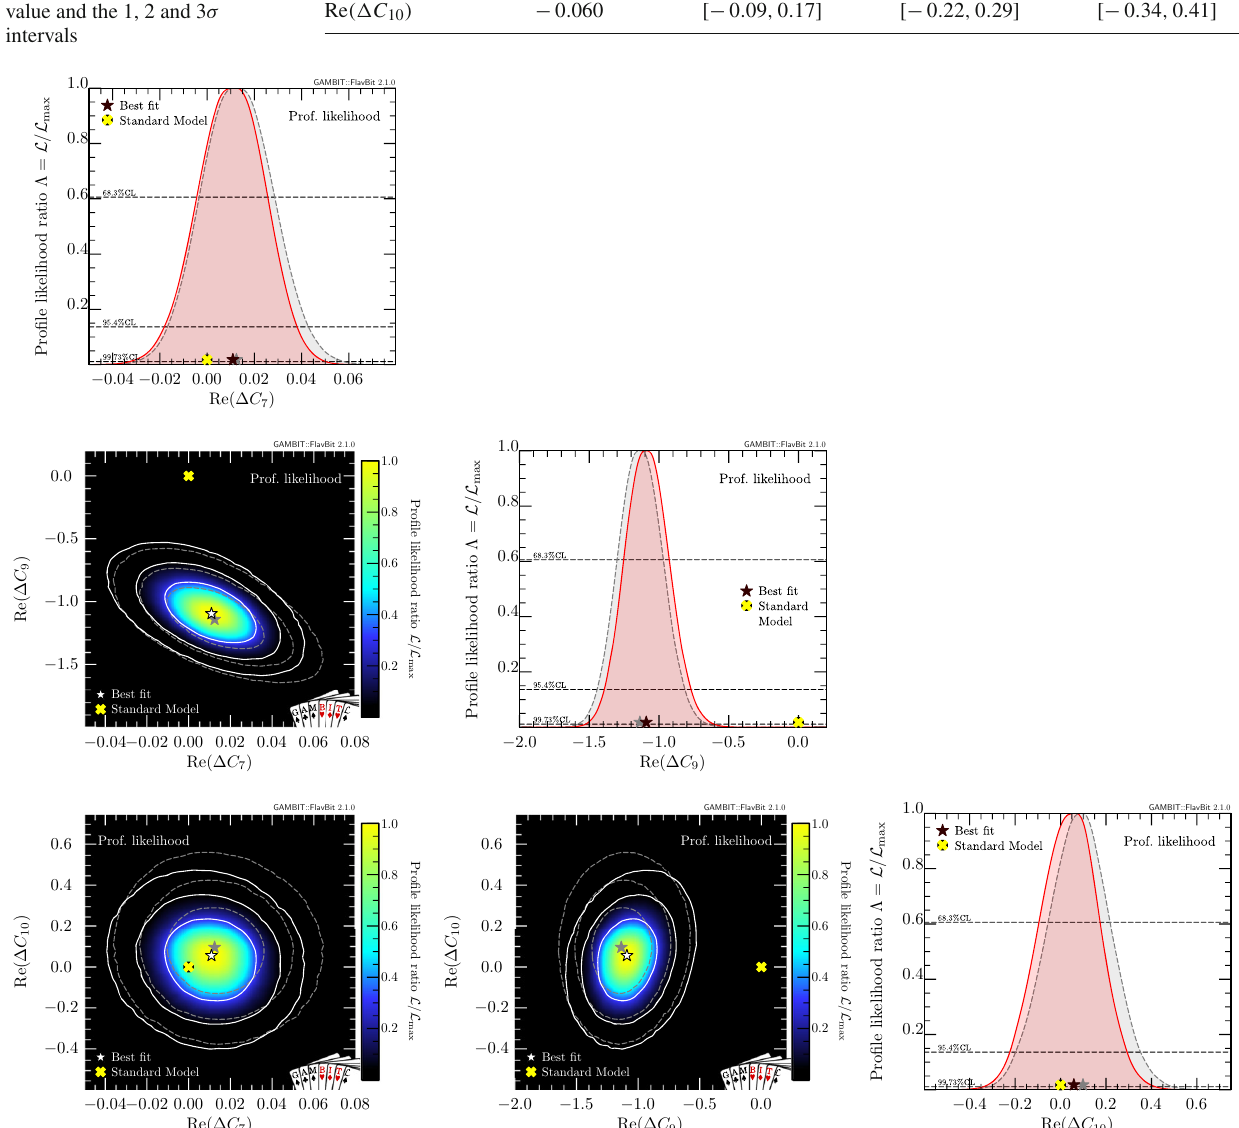
consistently for every combination of Wilson coefficients. Grey con- tours and curves show the corresponding result when we approximate the theory covariance by its value in the Standard Model, across the entire parameter space. The Standard Model prediction is indicated by a yellow